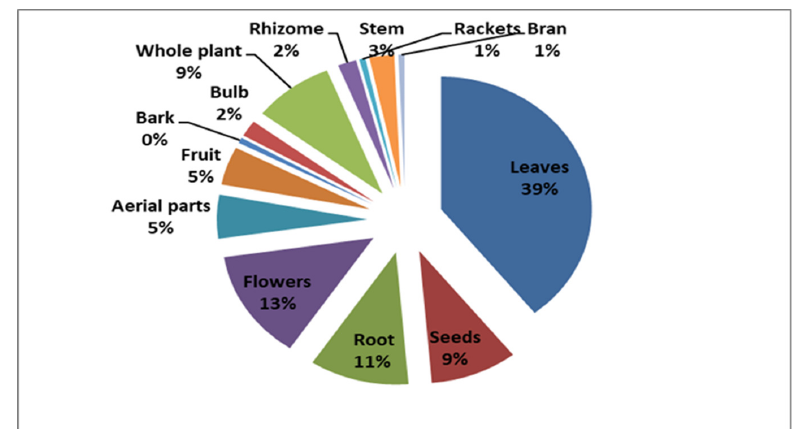
Figure 4. Percentage use of different plant parts against inflammation